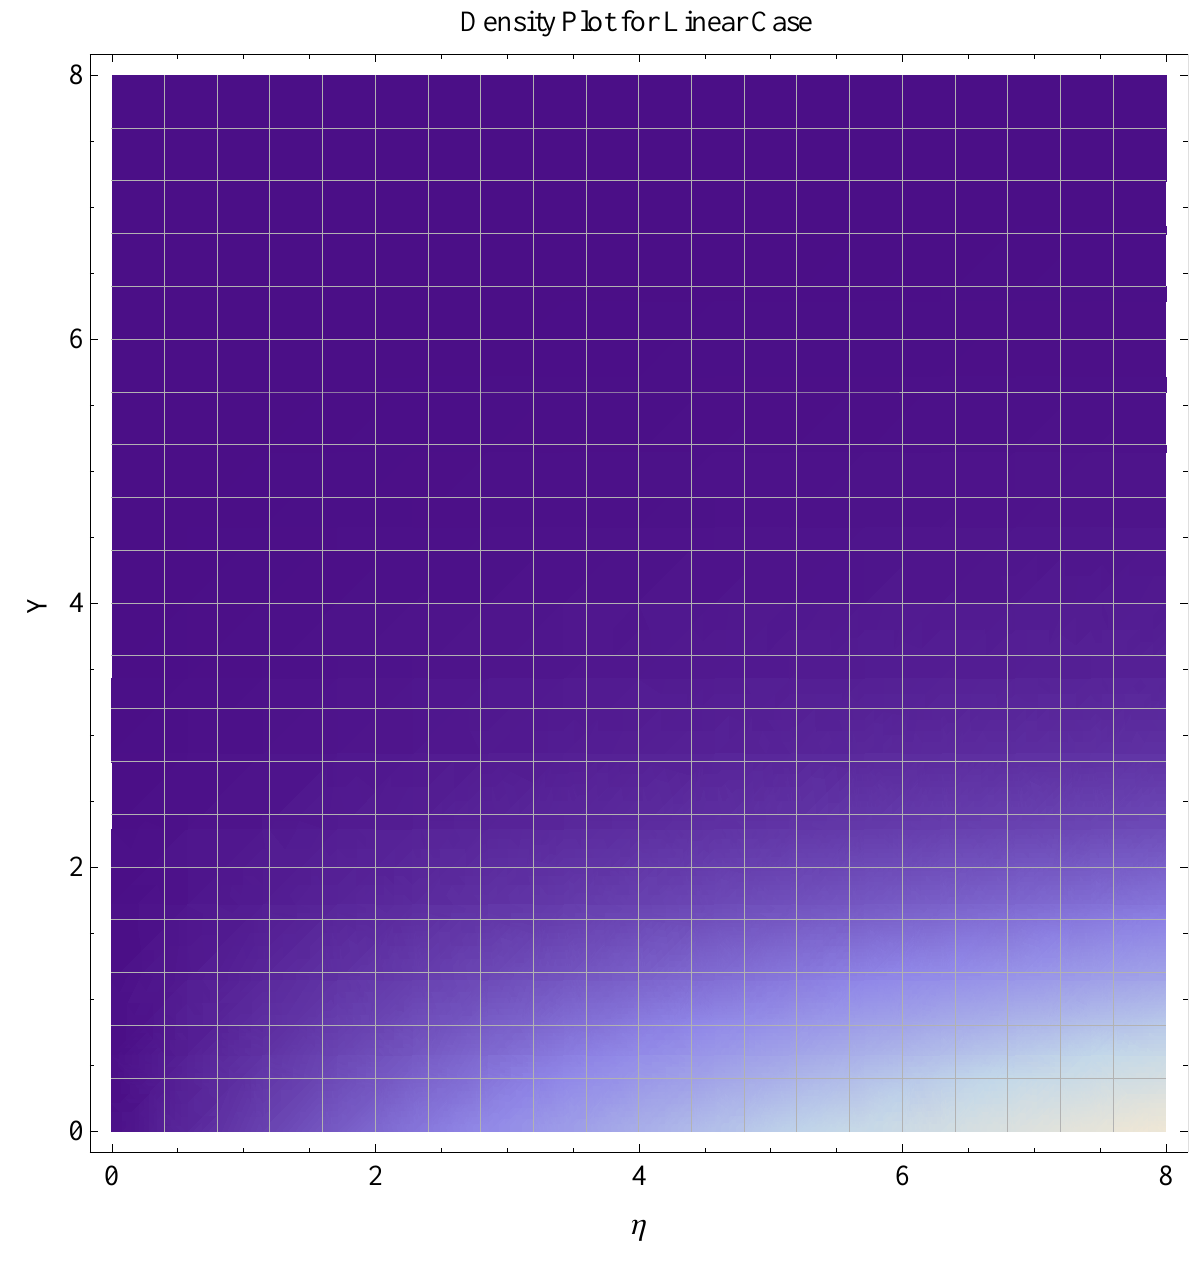
Figure 15. Density graph for linear